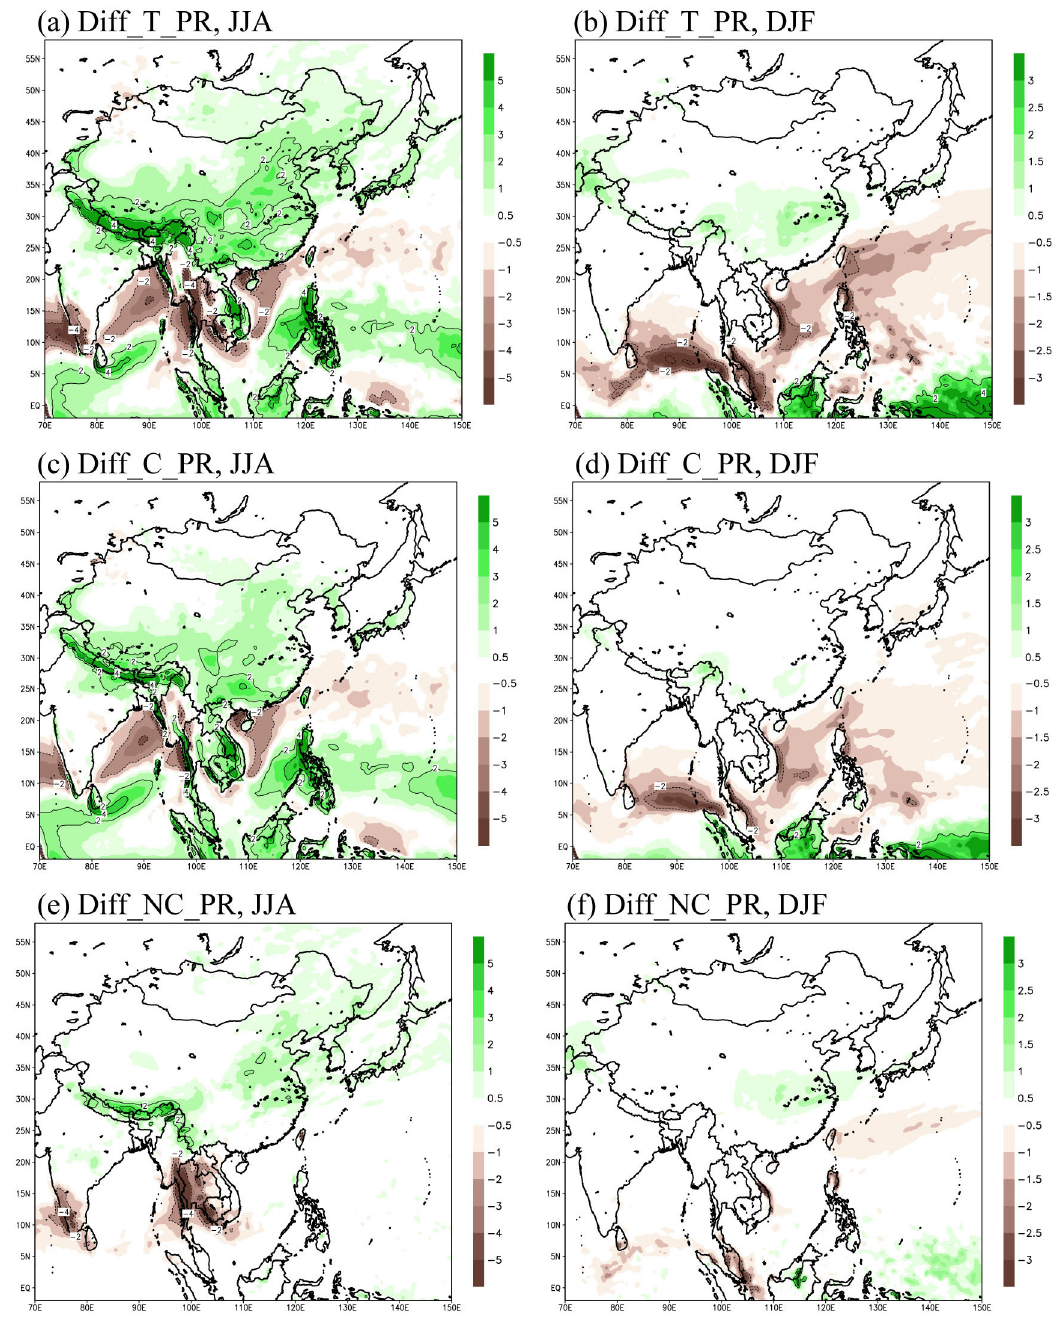
Figure 2. Spatial distribution of precipitation differences (mm/day) between ERA_ReC and R2_ReC over 20 years (1989–2008). Left and right panels are the results for summer (JJA) and winter (DJF), respectively. Upper, middle, and lower panels indicate the differences in total precipitation (T_PR), convective precipitation (C_PR), and non-convective precipitation (NC_PR), respectively. To show a clear comparison of RegCM4’s performance for precipitation, different color bar scales were applied for summer and